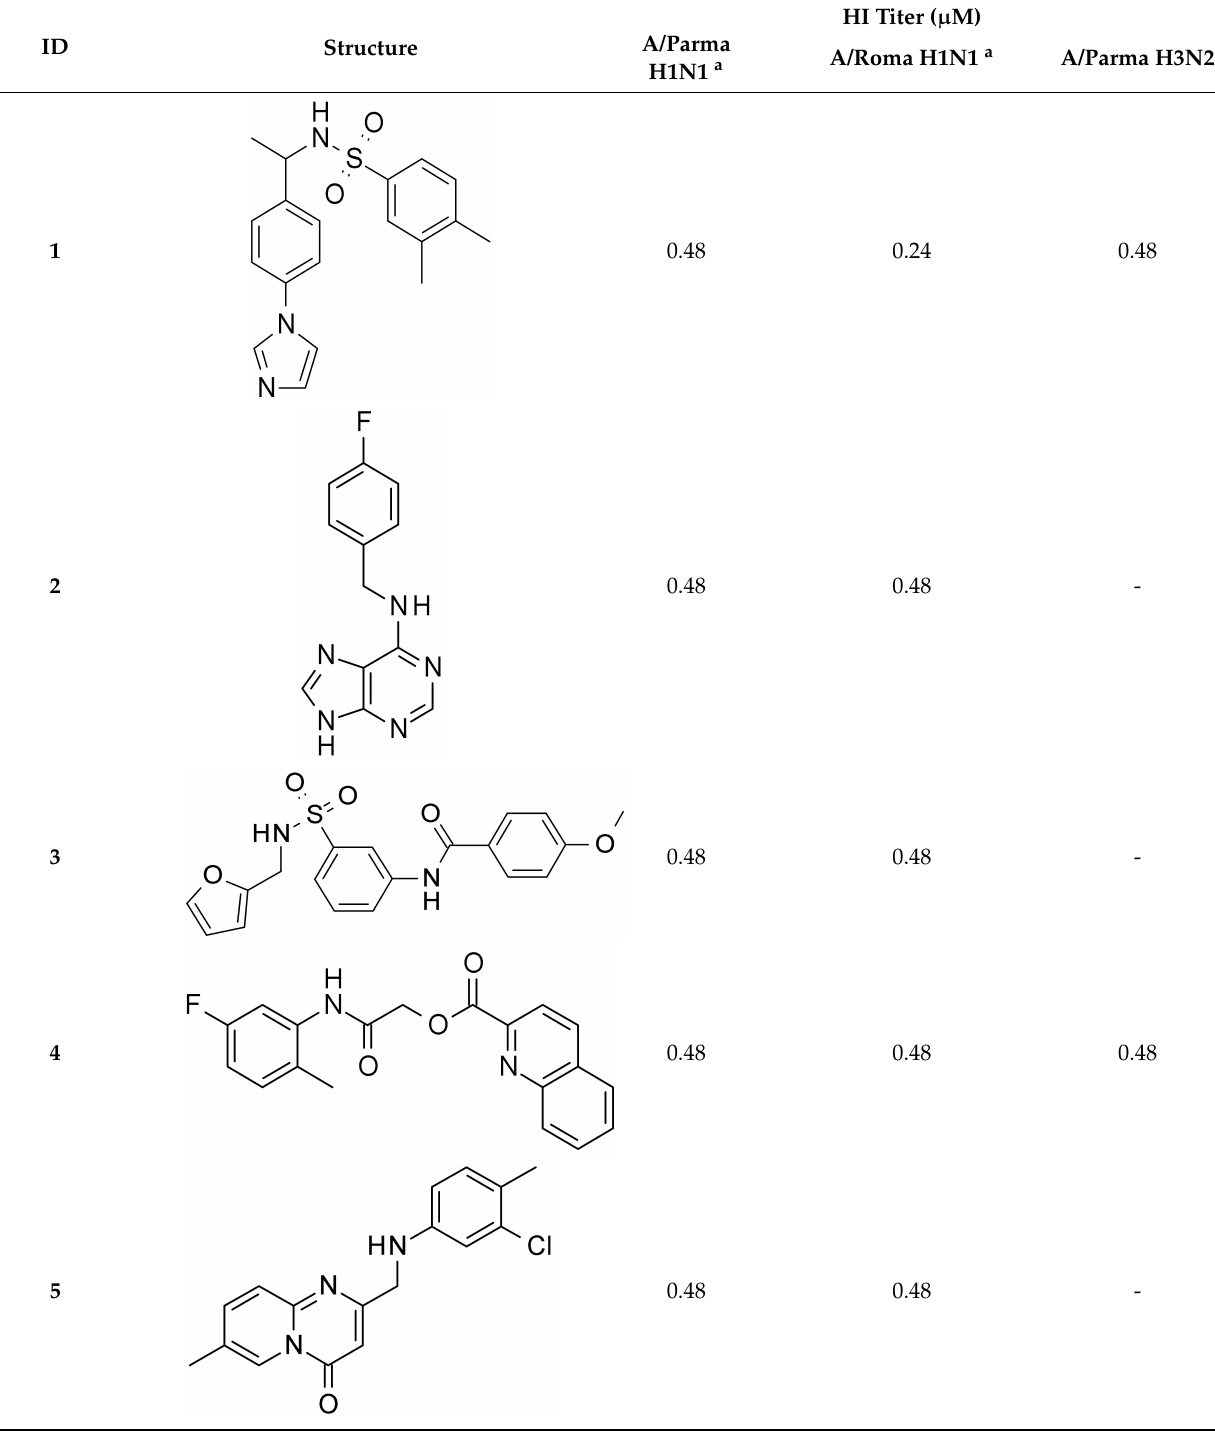
Table 1. HI titers of compounds 1 – 5 on the three studied viral